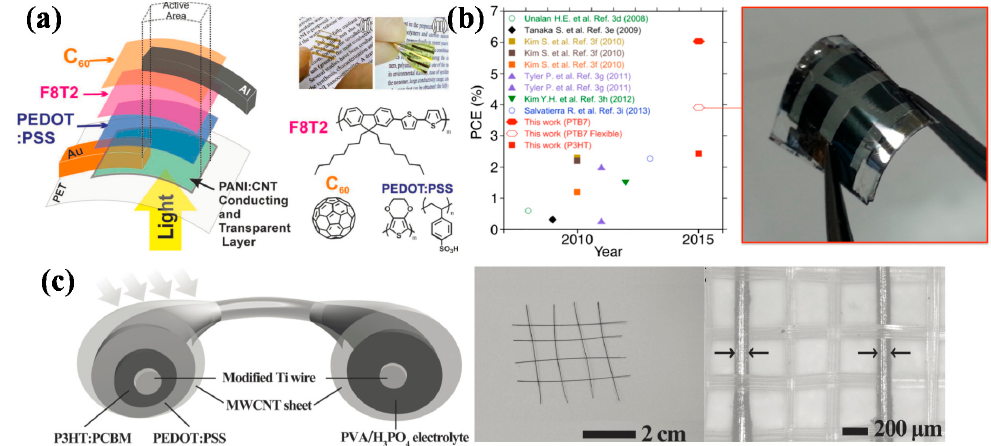
Figure 2. ( a ) The configuration of the solar cell built over a PET/PANI:CNT5 film, and the corresponding chemical structures of the organic layers. The photographs show the PET/PANI:CNT5 film (I) and the flexible solar cell (II). Reproduced with permission from [43]; published by John Wiley and Sons, 2013. ( b ) Reported PCEs of CNT organic solar cells (OSCs) on glass (closed symbols) and on flexible substrate (open symbols) ( left ) and a picture of the present PET-based flexible SWCNT OSC ( right ). Reprinted with permission from [44]. Copyright 2015 American Chemical Society. ( c ) Schematic illustration to the structure of all-solid-state, coaxial and integrated fiber device, corresponding to the PC and ES parts ( left ). “Energy fibers” being woven into a textile structure with each other and photograph of two “energy fibers” being woven into a flexible aramid fibers textile ( right ). Reproduced with permission from [46]; published by John Wiley and Sons, 2014.